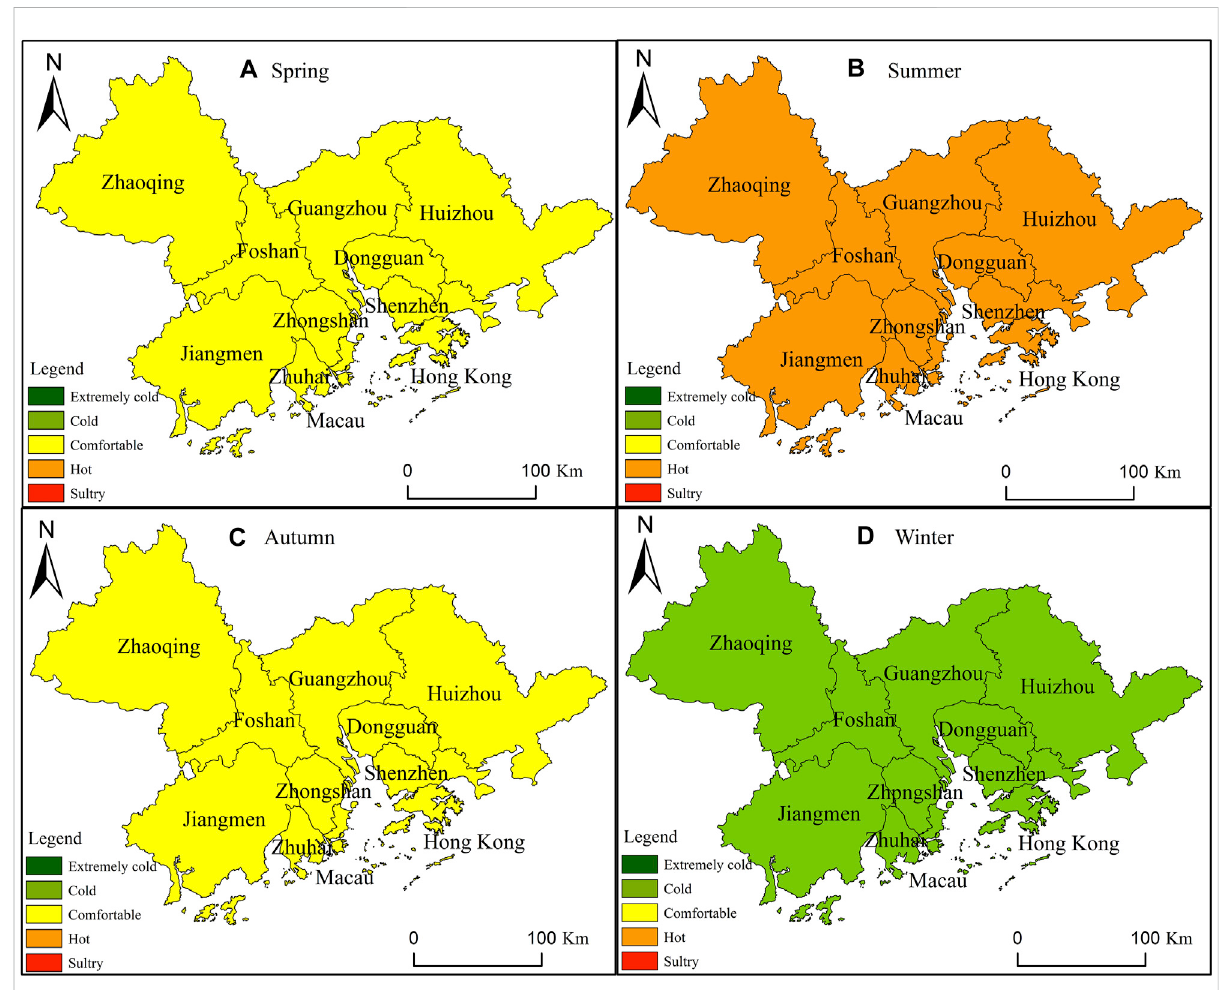
FIGURE 7 Seasonal change of climate comfort of human settlements in the Guangdong – Hong Kong – Macau Greater Bay Area in